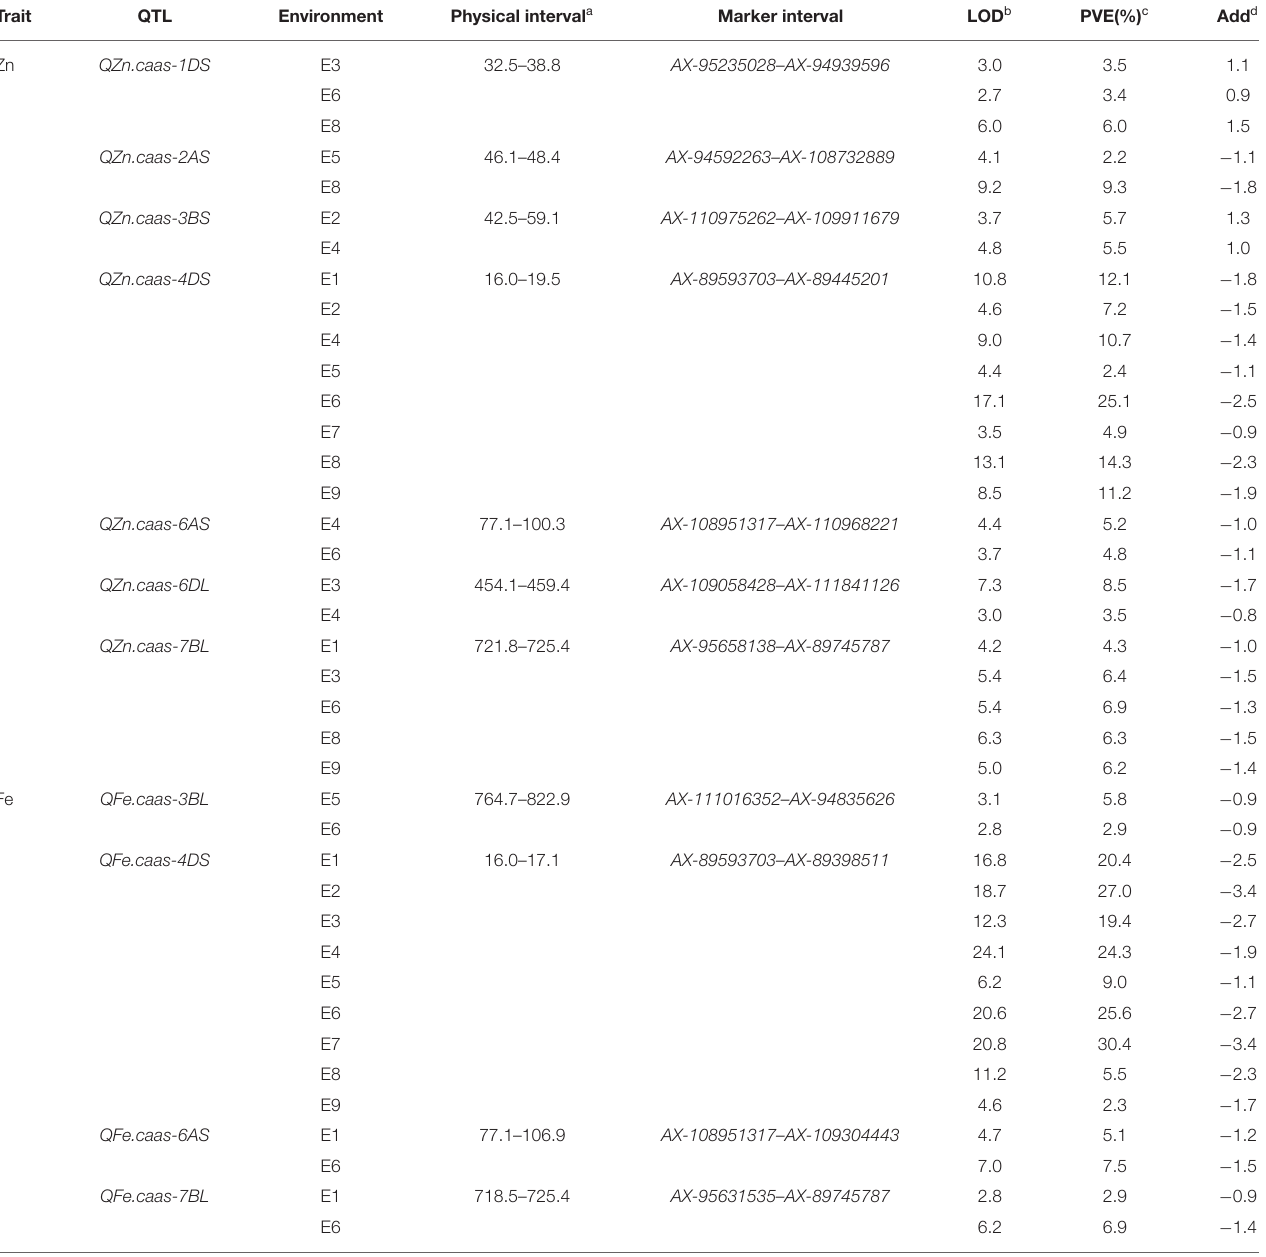
TABLE 4 | QTL for GZn and GFe identified by inclusive composite interval mapping in the Jingdong 8/Bainong AK58 RIL population. Trait QTL Environment Physical interval a Marker interval LOD b PVE(%)